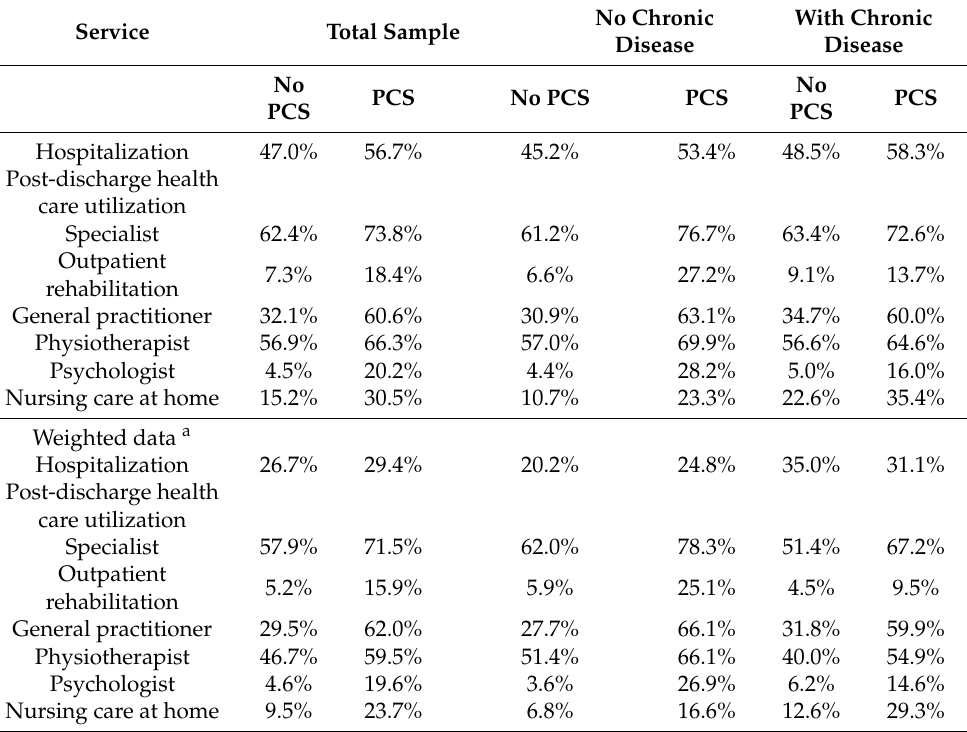
Table 5. Health care use within twelve months after injury by patients with and without post- concussion syndrome (PCS), by chronic disease